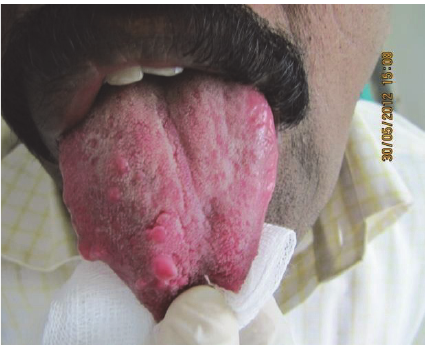
Figure 2: Intraoral examination of dorsum surface of the tongue showingmultiplenodularstructuresexhibiting“pebbly”appearance on the right side